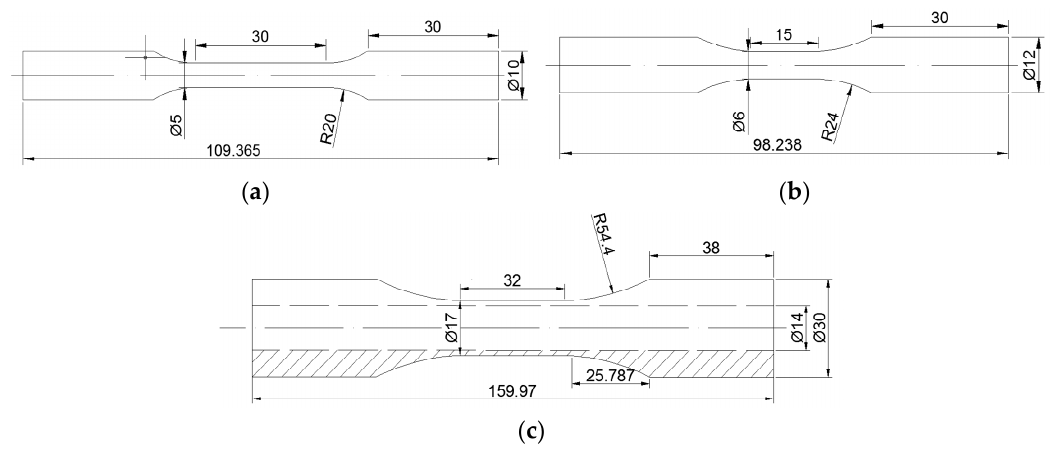
Figure 3. Specimens for fatigue tests (unit: mm): ( a ) Solid specimen for monotonic tests; ( b ) Solid specimen for axial tests; ( c ) Tubular specimen for torsional and multiaxial tests.